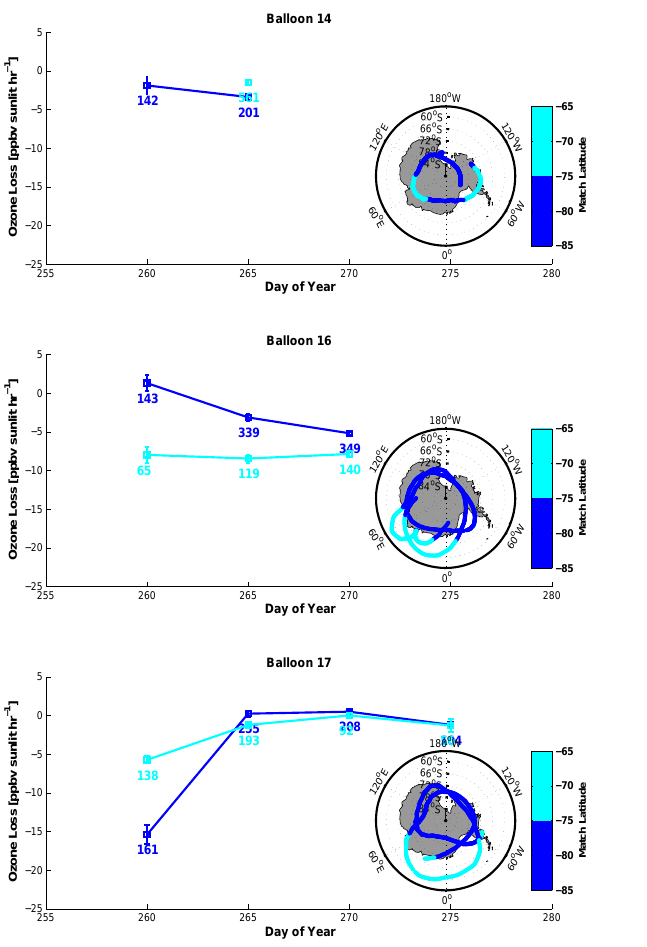
Figure 6. Ozone loss according to mean normalised PV of the